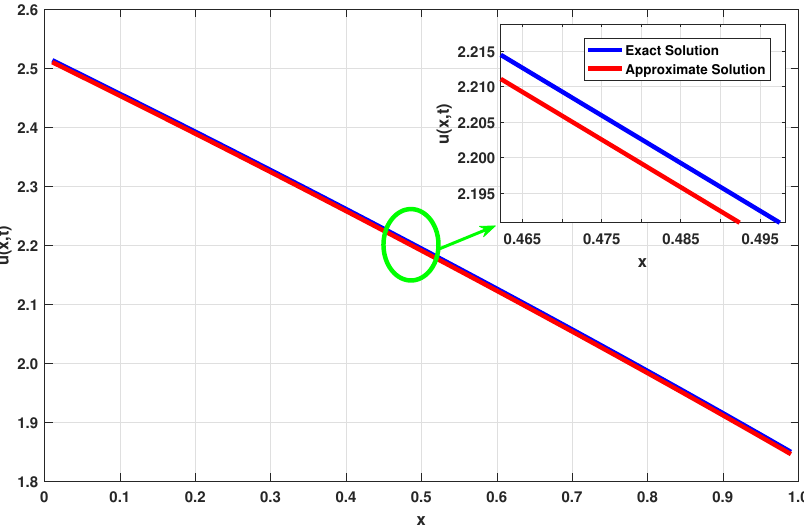
Fig. 2 Comparison of the exact and approximate solution for linearization 3 at